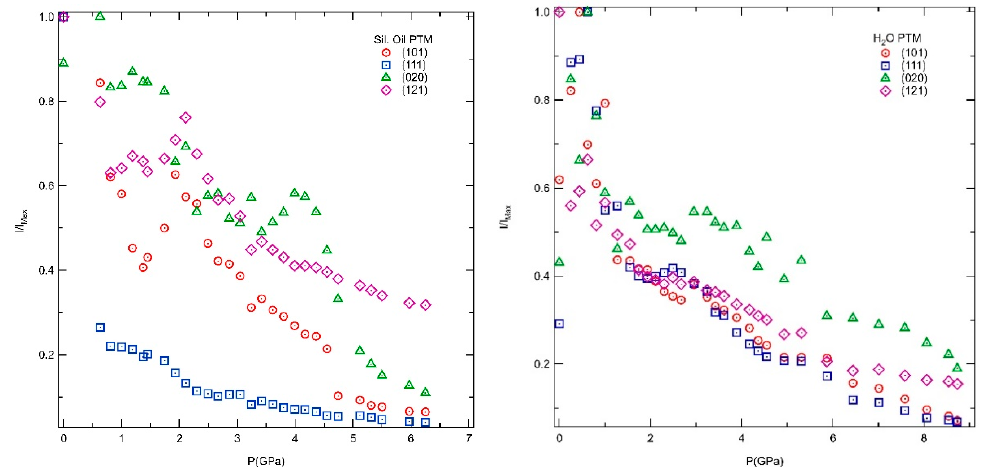
Figure 2. Normalized intensity (I / I Max ) of the 101, 111, 020 and 121 reflections of AlPO 4 -17 • x H 2 O as a function of pressure in both studied pressure transmitting media (PTM): silicone oil ( left ) and in H 2 O ( right ).